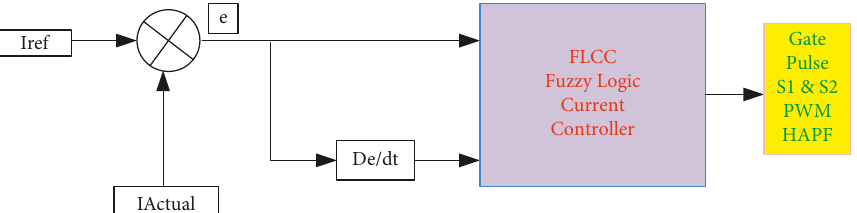
Figure 22: FLC (Fuzzy Logic Controller) based PWM (Pulse Width Modulation) for switching signals (S1 & S2) generation to trigger single- phase half-bridge HAPF.